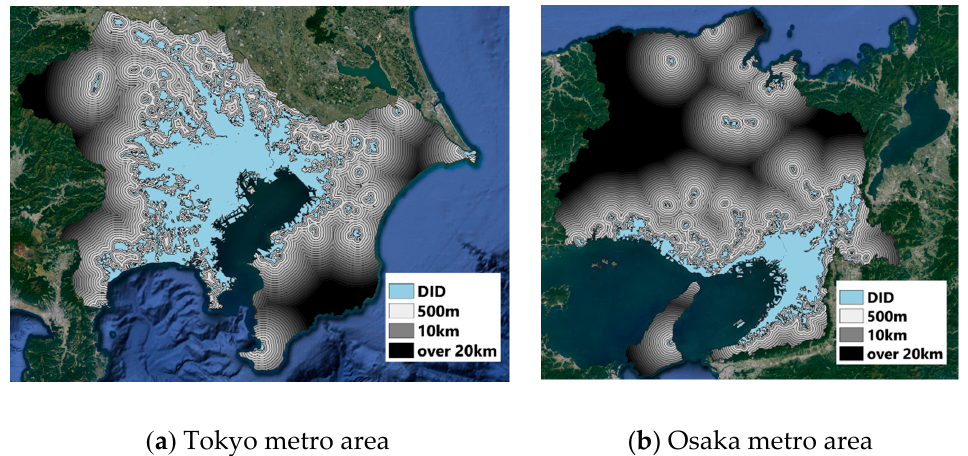
Figure 2. Stratified buffers by distance from DID. ( a ) includes Tokyo, Kanagawa, Chiba and Saitama. ( b ) includes Osaka, Kyoto and Hyogo.